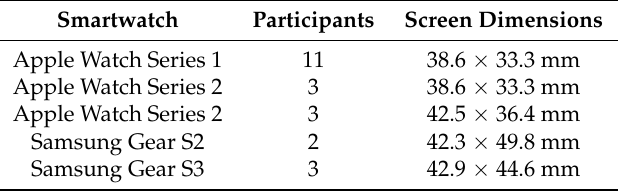
Table 3. Participant distribution across smartwatches in terms or smartwatch type and screen